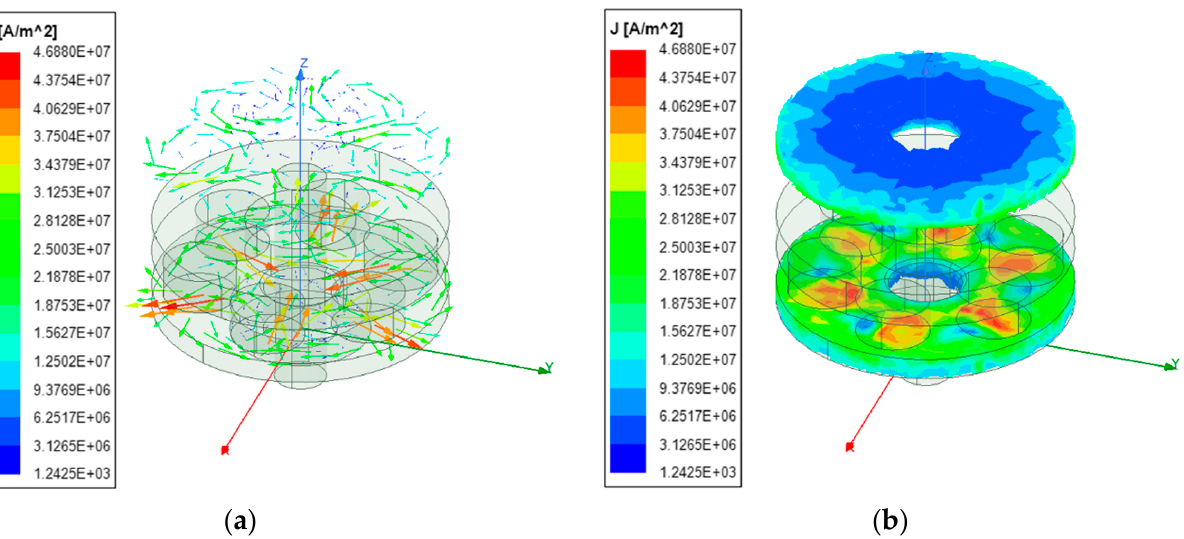
Figure 15. Transient eddy current density distribution of the rotor disks: ( a ) Vector distribution; ( b ) Field distribution.